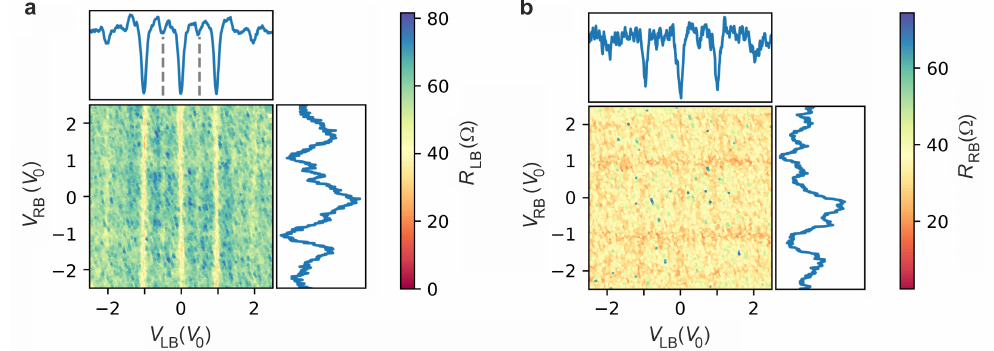
Figure 6. Shapiro step measurements at 8.5GHz: ( a ) Numerically determined differential resistance R LB as a function of the normalized voltage drops V LB / V 0 and V RB / V 0 at 8.5GHz and rf power of 0dBm, with V 0 = hf rf /2 e . The blue curves represent the averaged signal along V LB / V 0 and V RB / V 0 , respectively. The dashed lines indicate the half-integer steps. ( b ) Corresponding map of the differential resistance R RB